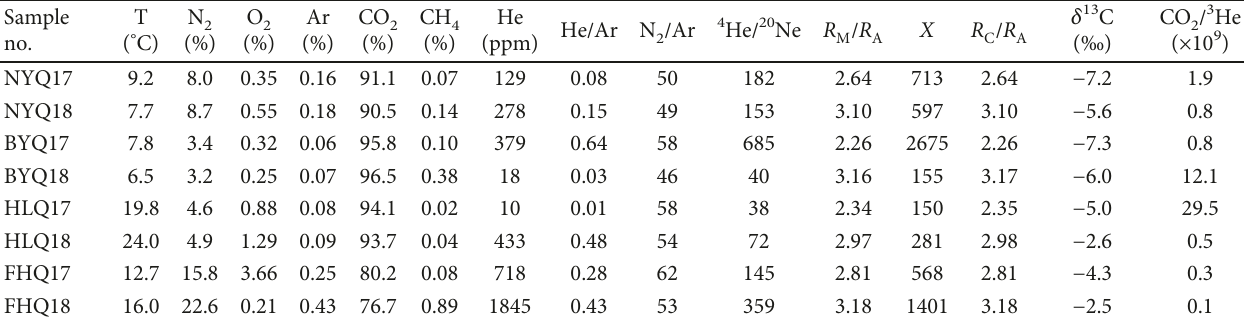
Table 1: Chemical and C-He isotopic compositions of the spring gases in the WMVF. Sample